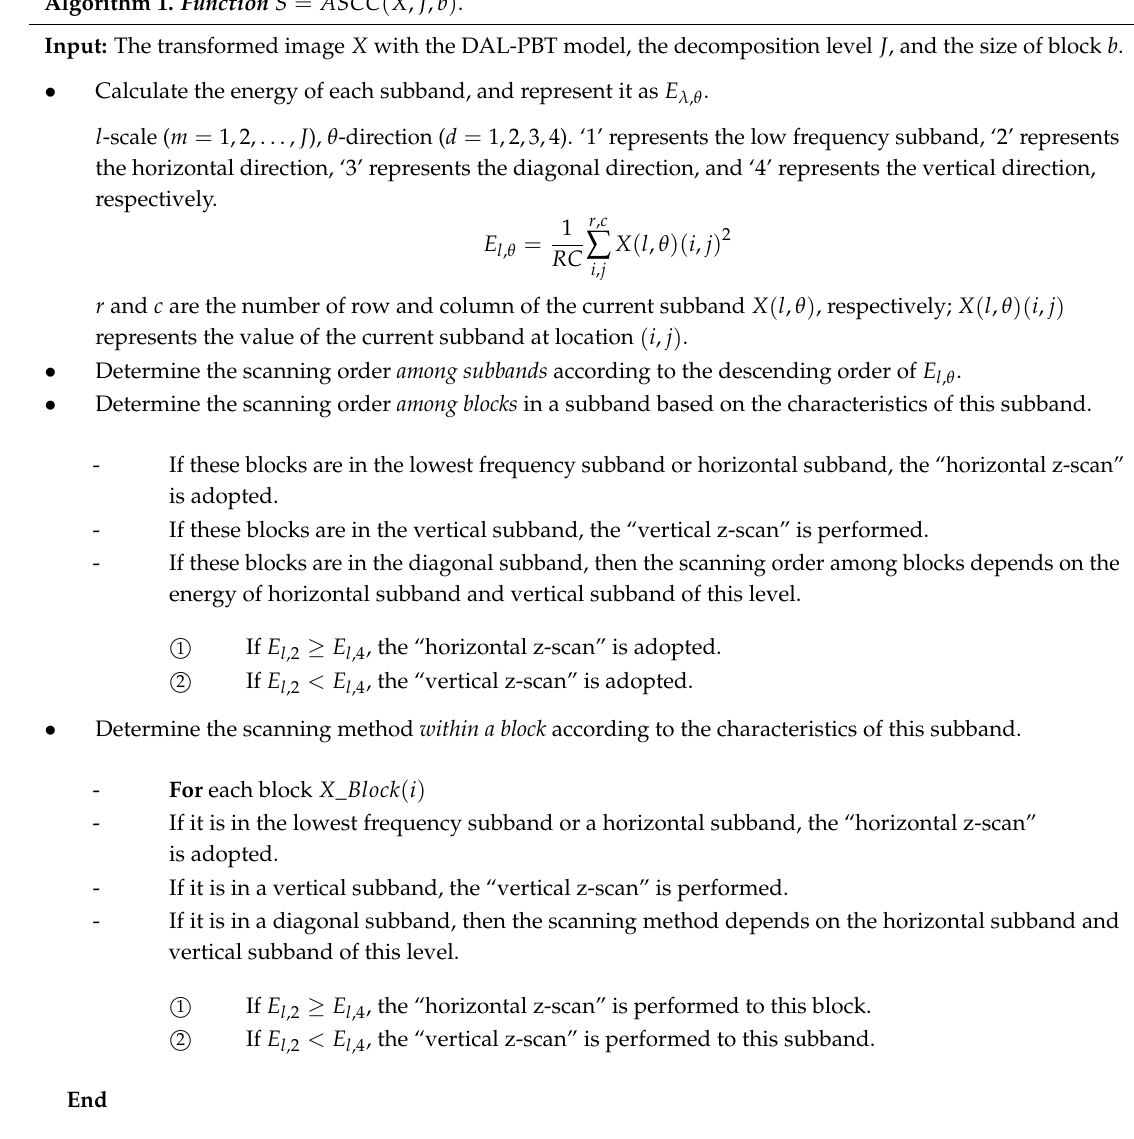
Algorithm 1. Function S = ASCC ( X , J , b )